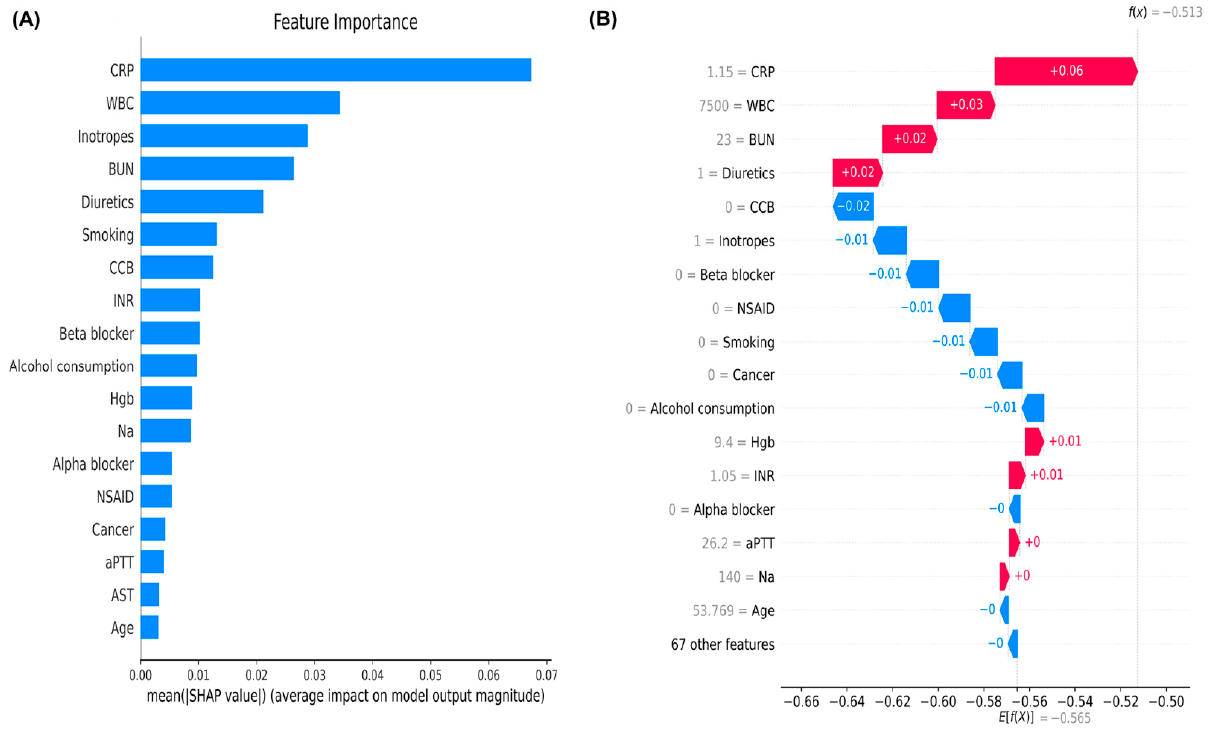
Figure 2. ( A ) The feature importance plot using SHAP value reveals the important features in the final LGBM model ( B )The local bar plots of feature importance reveal the SHAP values for features in the model. The feature values are show in gray to the left of the feature names. Abbreviations: SHAP, SHapley Additive exPlanation; LGBM, light gradient boosting machine; CRP, C-reactive protein; WBC, white blood cell counts; BUN, blood urea nitrogen; CCB, calcium channel blocker; INR, international normalized ratio; Hgb, hemoglobin; Na, sodium; NSAID, non-steroidal anti-inflammatory drug; aPTT, activated partial thromboplastin time; AST, aspartate aminotransferase; INR, international normalized ratio.